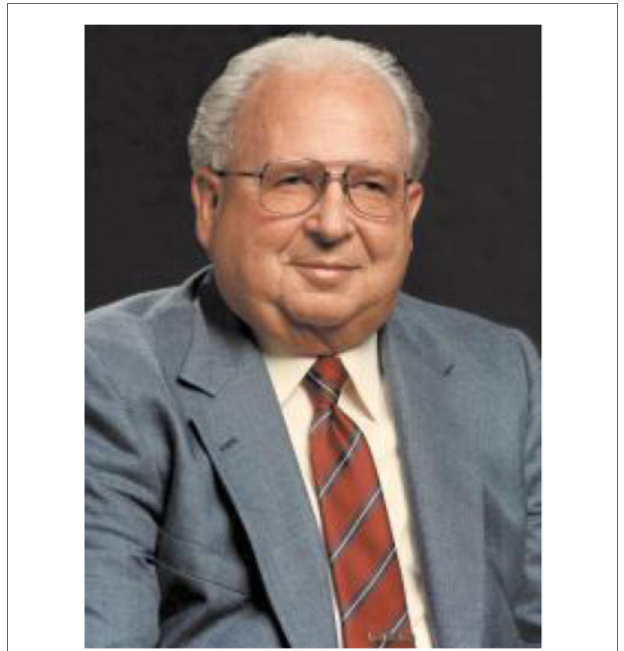
FiGURe 1 | Don Stookey